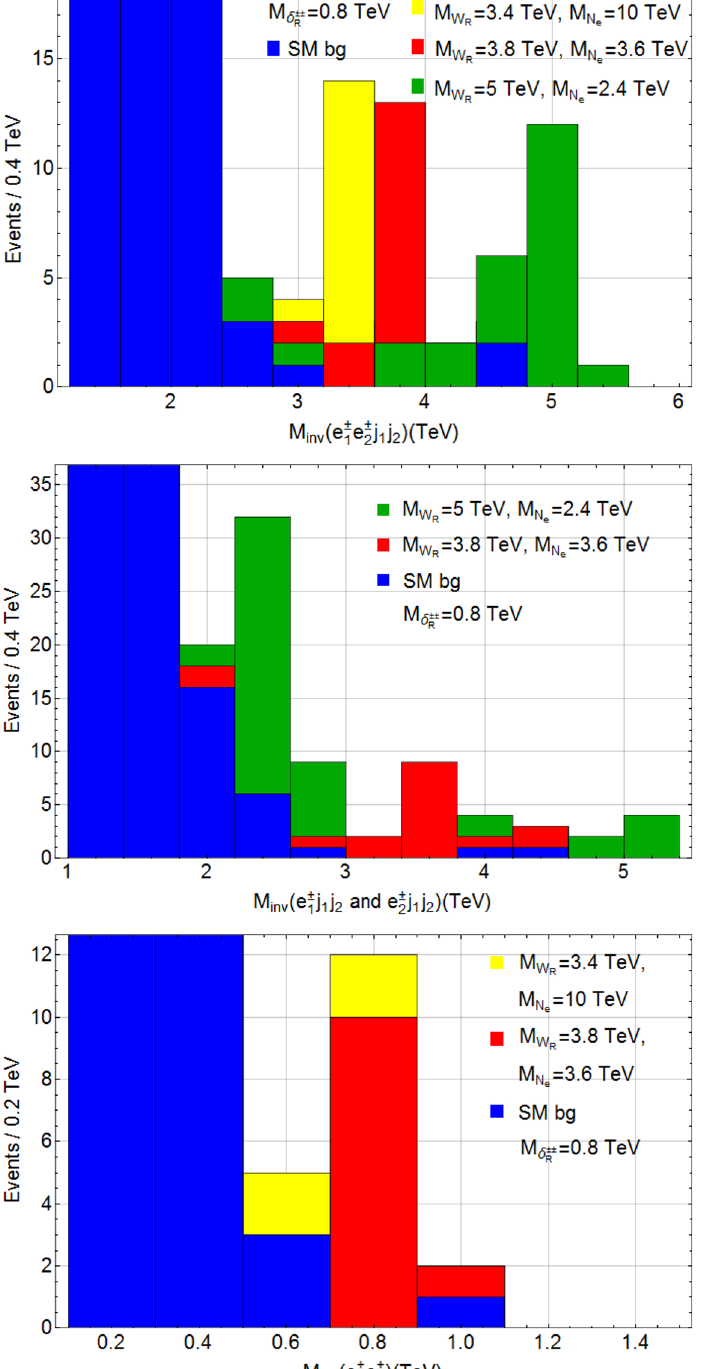
Figure 5. Mass reconstructions of M W 14 TeV LHC. The reconstructions are performed with the signal and background selected events as a function of the invariant mass of the e ± (middle panel) and the e ± three mass sets used in this figure are marked in figure